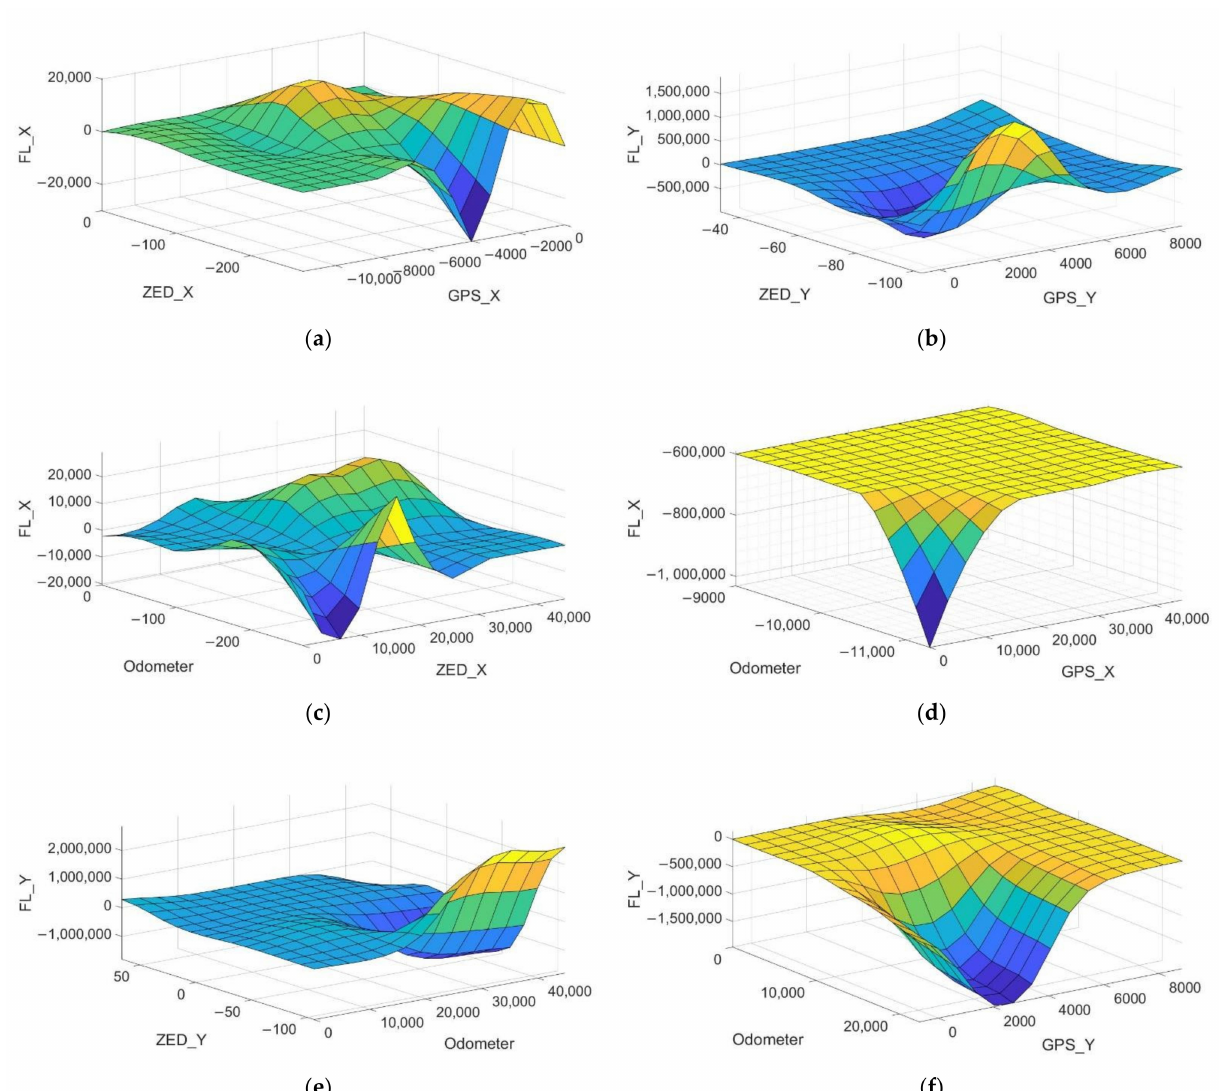
Figure 8. Set of input-output graphs ( a – f ) in groups of two inputs-one output to observe the response of the fuzzy fusion system of five inputs two outputs. ( a ) Resulting surface from the causality of the ZED and GPS latitude inputs in the FL system. ( b ) Resulting surface from the causality of the GPS and ZED longitude inputs in the FL system. ( c ) Resulting surface from the causality of the GPS latitude and odometer inputs in the fuzzy logic system. ( d ) Resulting surface from the causality of the ZED camera latitude and the odometer inputs in the fuzzy logic system. ( e ) Resulting surface from the causality of the ZED camera latitude and odometer inputs in the fuzzy logic system. ( f ) Resulting surface from the causality of the ZED camera latitude and odometer inputs in the fuzzy logic